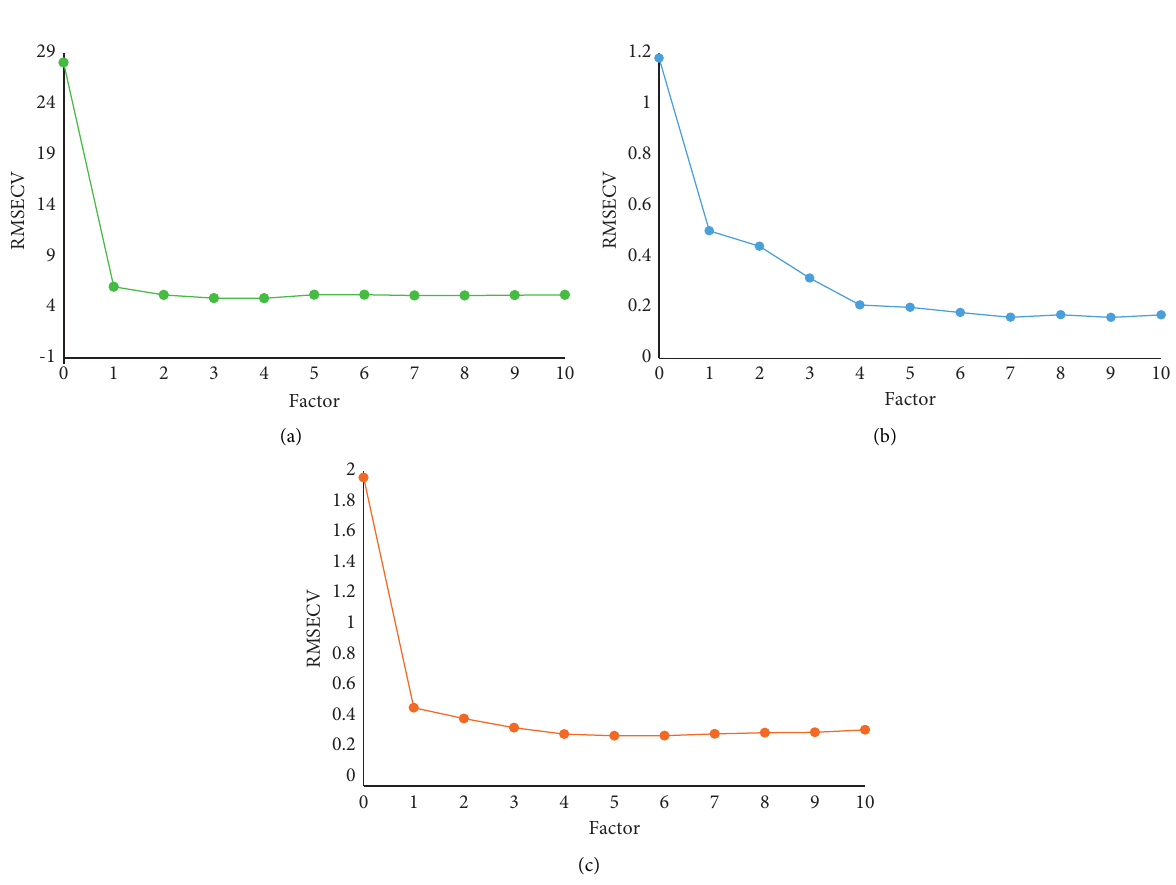
Figure 8: The variation of RMSECV with different principal factor numbers: (a) moisture, (b) caffeine, and (c) EGCG. Table 5: Validation results of the method.